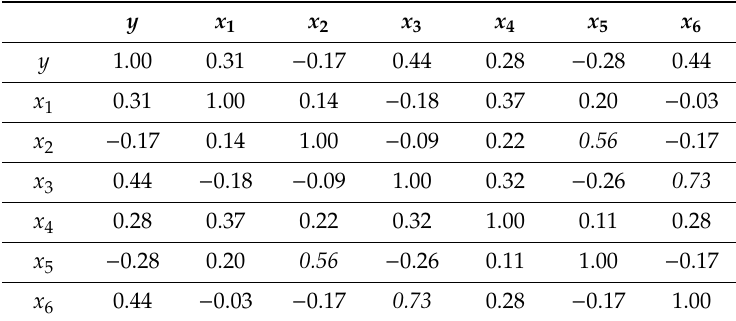
Table 6. Correlation matrix for the dependent and independent variables (significant coe ffi cients ( p < 0.05) are highlighted).